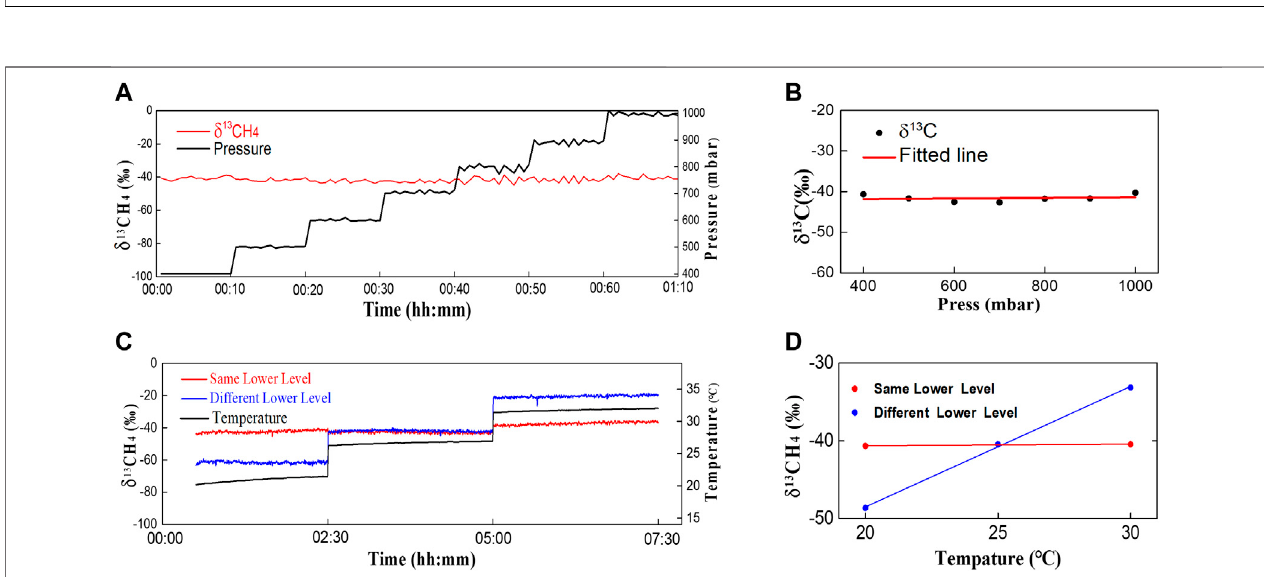
FIGURE 8 | δ 13 CH 4 in the pressure and temperature sensitivity test. (A) δ 13 CH 4 and pressure reading in pressure test; (B) δ 13 CH 4 -pressure dependence analysis; (C) δ 13 CH 4 and temperature reading in temperature test for choice B (red) and choice C (blue); (D) δ 13 CH 4 -temperature dependence analysis for choice B (red) and choice C (blue).